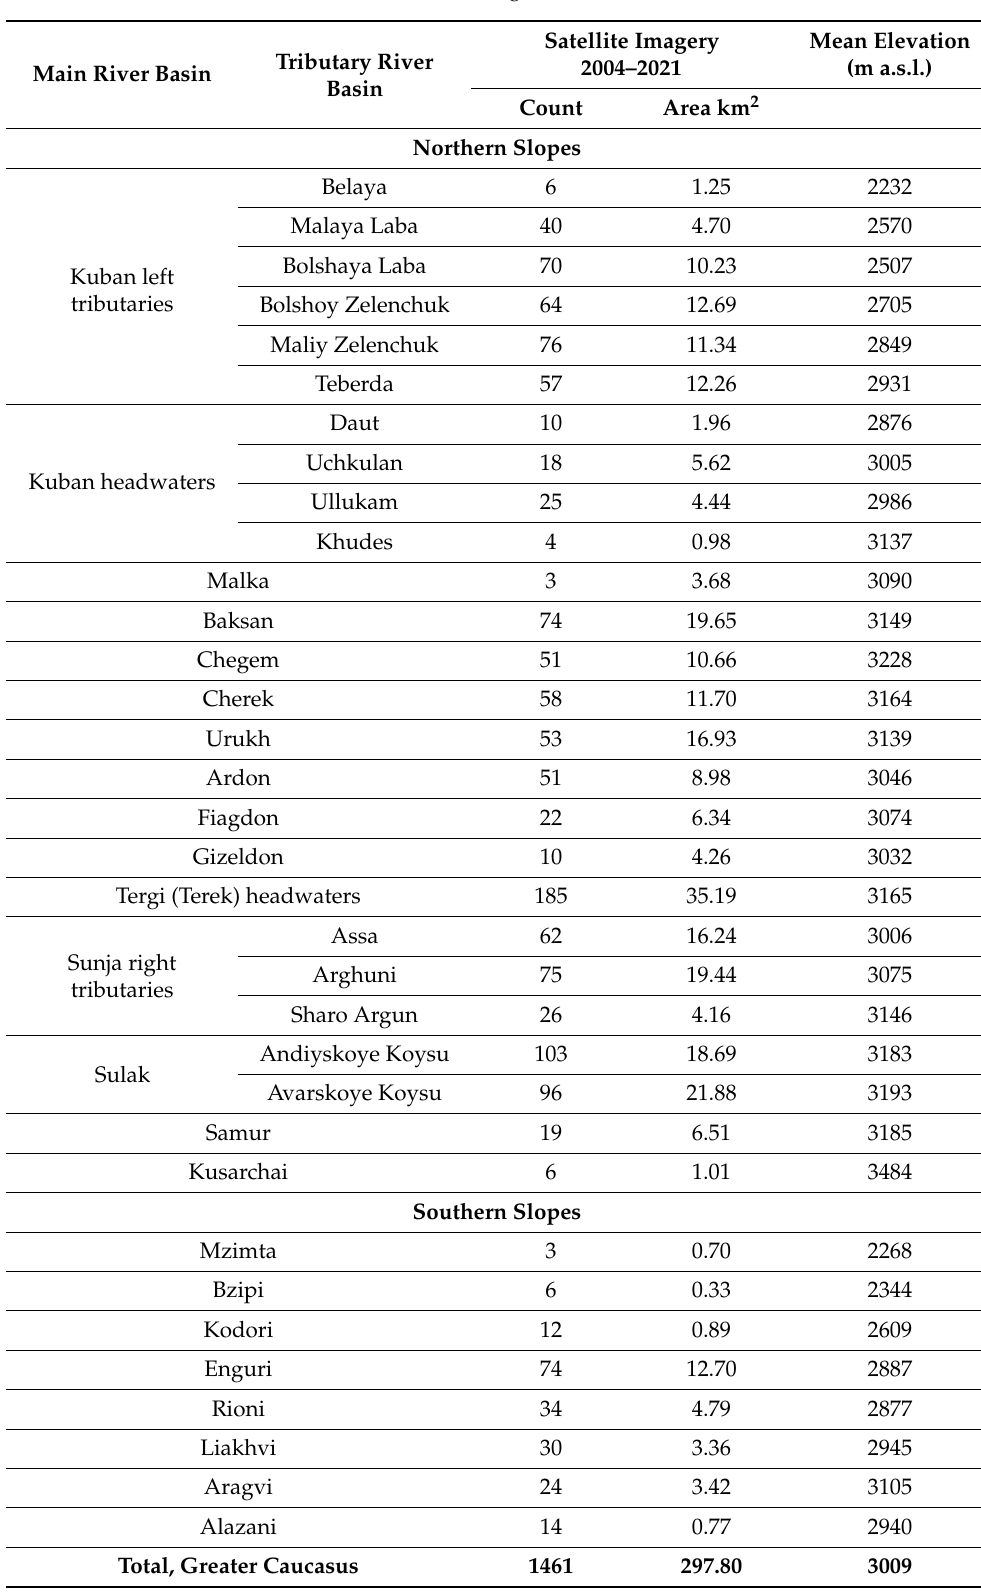
Table 2. The distribution of rock glaciers in the Greater Caucasus by slopes and individual river basins in order from west to east. Please also see Figure 1 for locations of river